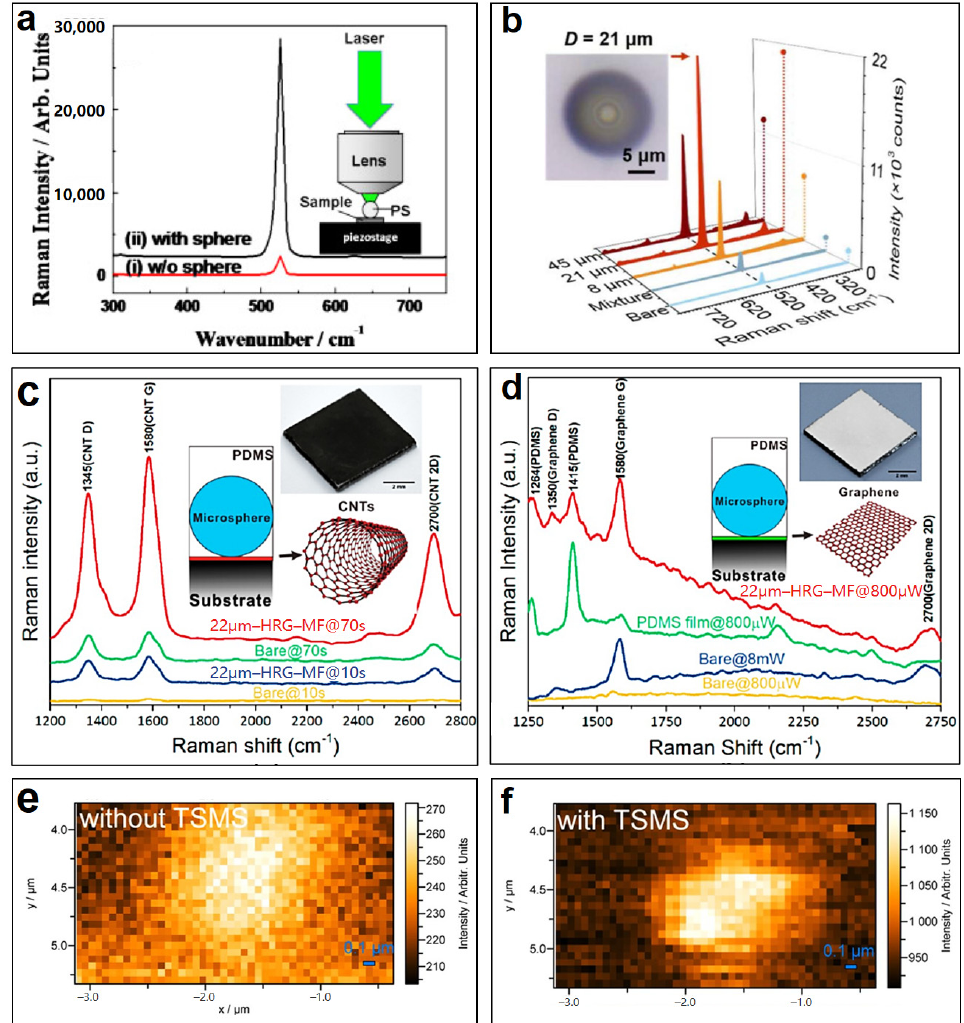
Figure 6. Raman enhancement of the microsphere lens. ( a ) Raman spectra of a Si wafer without PS microsphere (i) and with PS microsphere (ii); ( b ) Raman scattering intensity of different diameters of C 10 H 7 Br microlenses on silicon wafers; Raman spectra of microspheres with and without high refractive index on ( c ) 1D carbon nanotubes and ( d ) 2D graphene; Raman mapping ( e ) with and ( f ) without microlens.